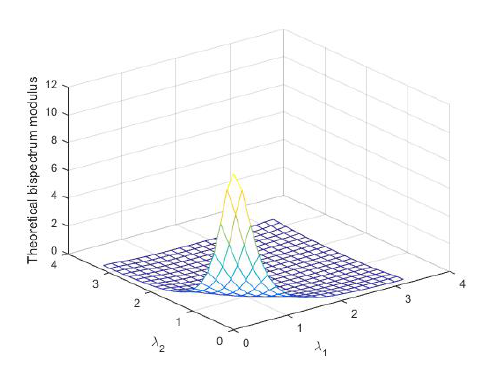
Figure 3. The theoretical bisectral modulus of the